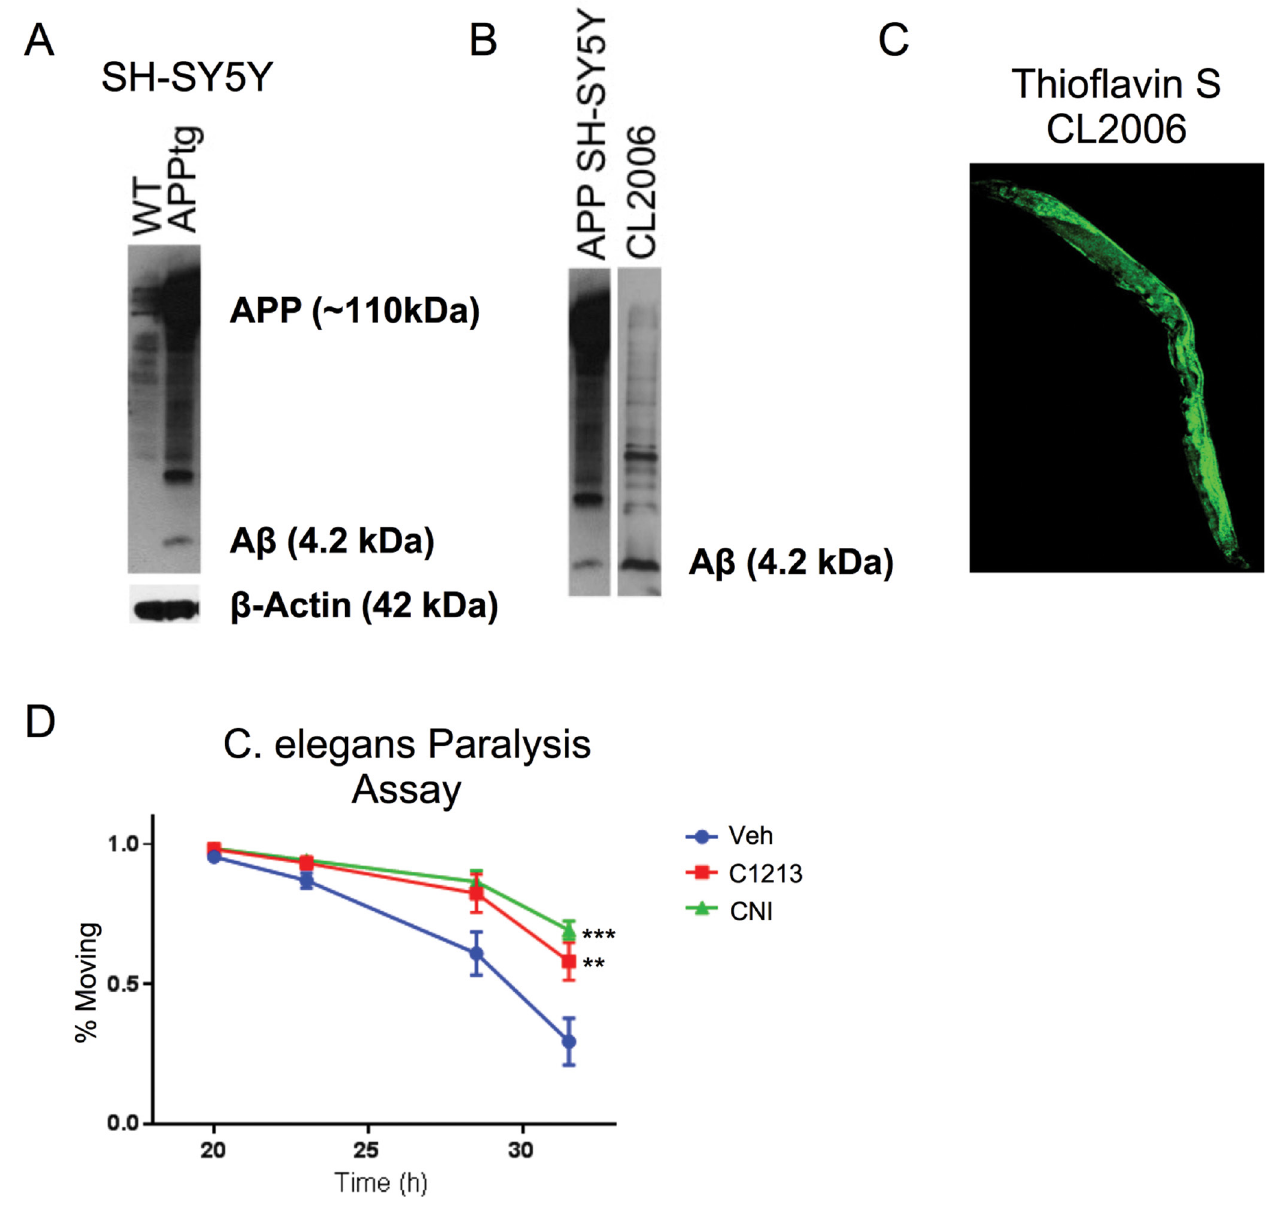
Figure 5. C1213 and CNI-1493 attenuate in vivo A β 1-42 toxicity in C. elegans . (A) Western blot of the cytosolic fraction of amyloid pre- cursor protein overexpressing SH-SY5Y shows a band consistent with cytosolic A β that is not present in wild-type cells. (B) Western blot of the CL2006 C. elegans model of muscular A β 1-42 overexpression and paralysis shows A β reactivity in worm lysates. (C) CL2006 A β 1-42 overexpressing worms were stained with Thioflavin S and visualized using confocal microscopy. (D) CNI-1493 and C1213 attenuate A β - induced paralysis in the CL4176 C. elegans model of muscular A β 1-42 overexpression and paralysis. ** P < 0.01 Veh vs. Compound; *** P < 0.001 Veh vs.